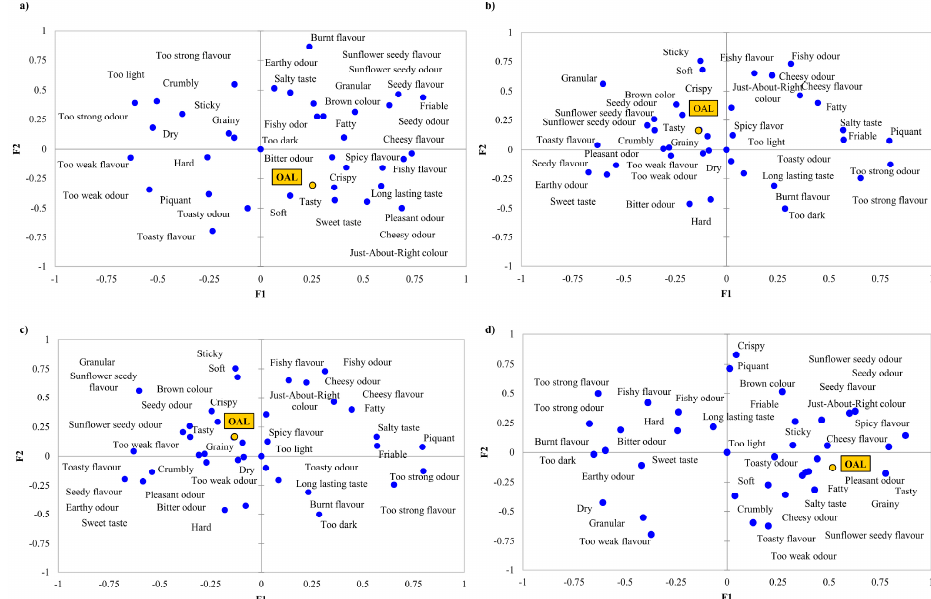
Figure 3. Principal coordinate analysis (PCoA) plots of the four samples. ( a ) CP0—0 g / 100